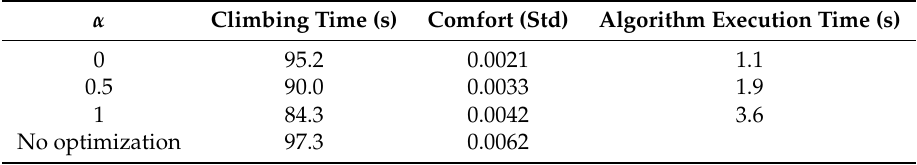
Figure 33. Path of the center of mass ( P g ) when the optimization is carried out with α equal to zero ( — ) and when the optimization is not considered ( — ). Table 7. Results